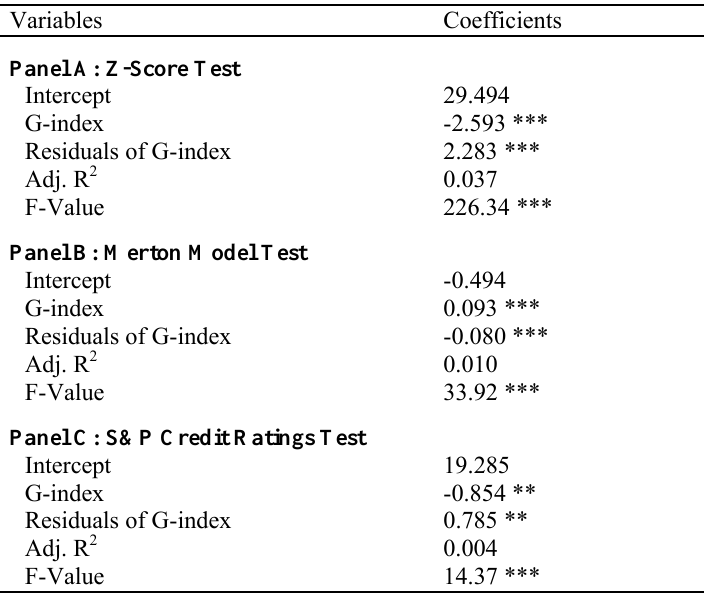
Table 2. Durbin-Wu-Hausman Endogeneity Test